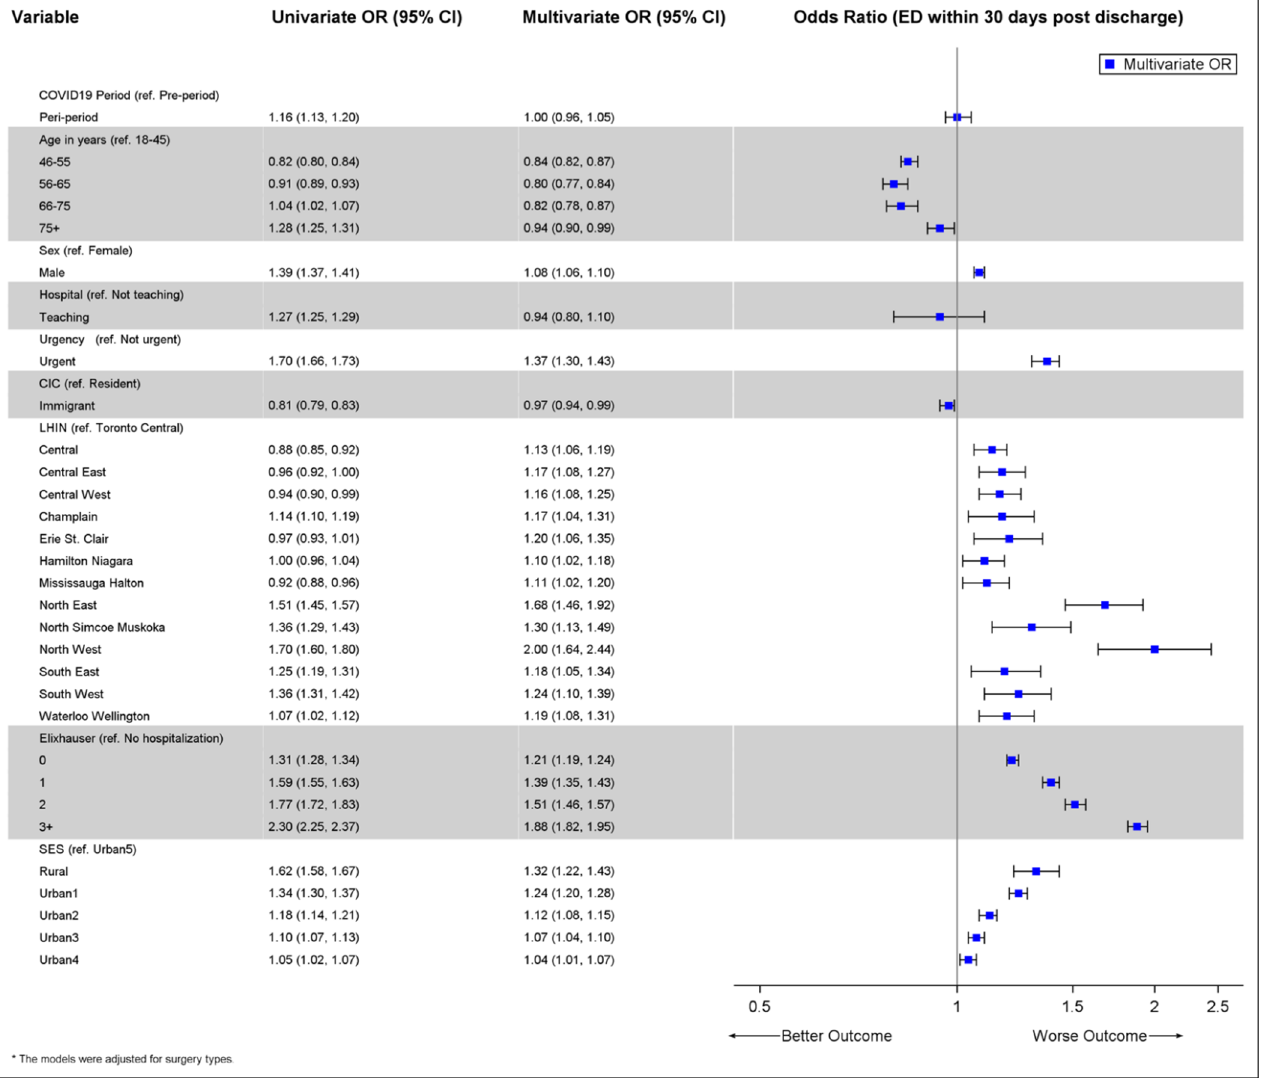
Figure 3. Forest plot illustrating the associations between characteristics and the odds of an ED visit within 30 days after discharge from cancer-directed surgery (among entire cohort of cancer-directed surgeries).